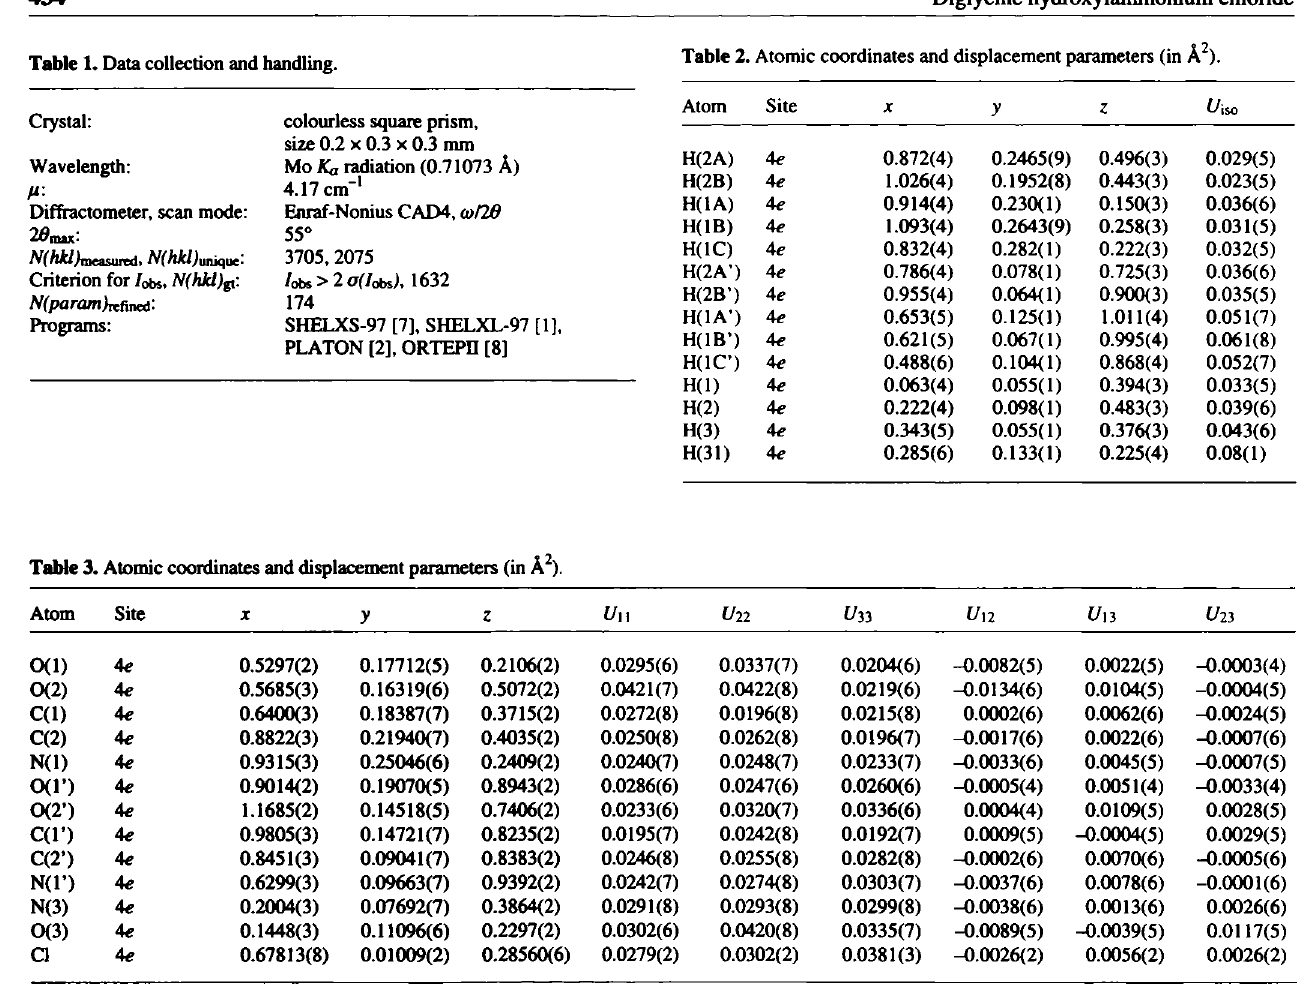
Table 3. Atomic coordinates and displacement parameters (in Â 2